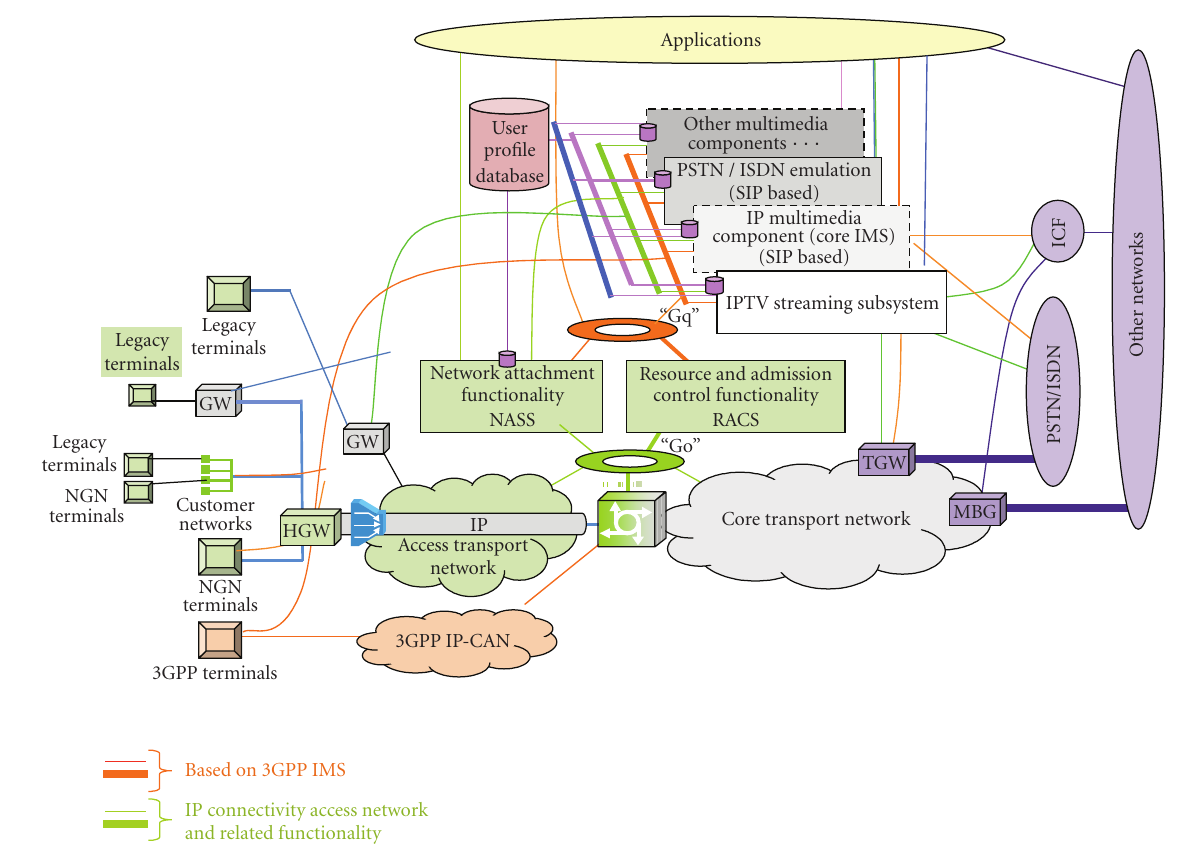
Figure 1: ITU-T and ETSI TISPAN NGN